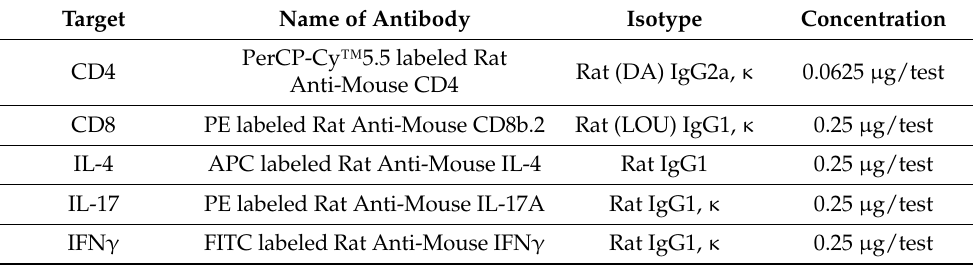
Table 1. Antibody targets, names, isotypes, and